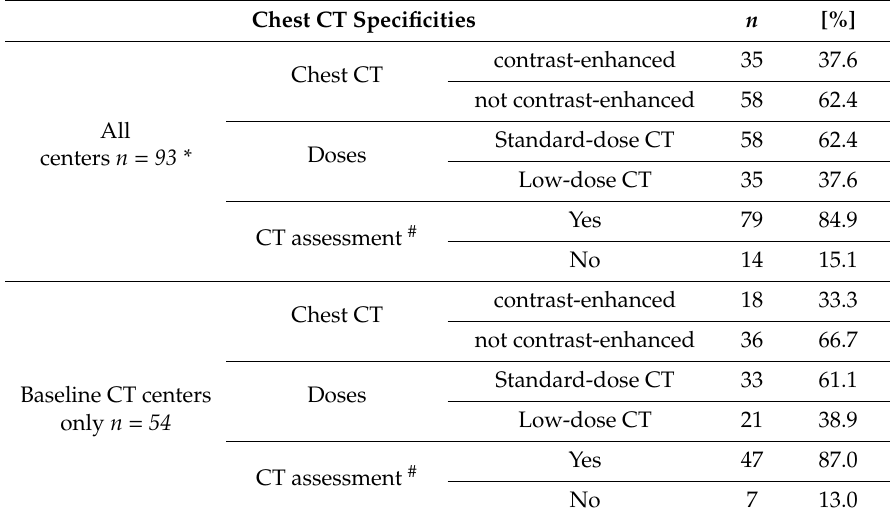
Table 3. Chest computed tomography (CT)